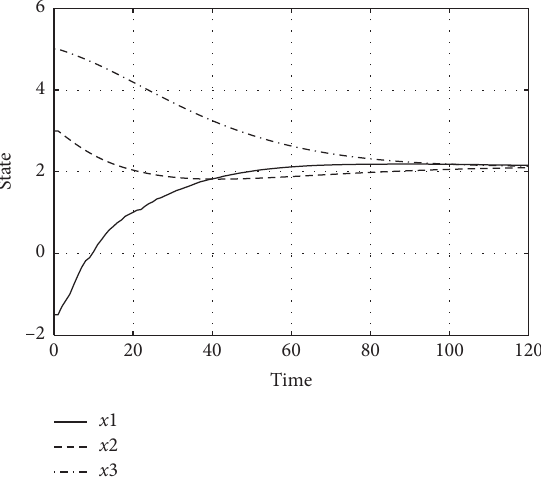
Figure 4: States of agents with communication